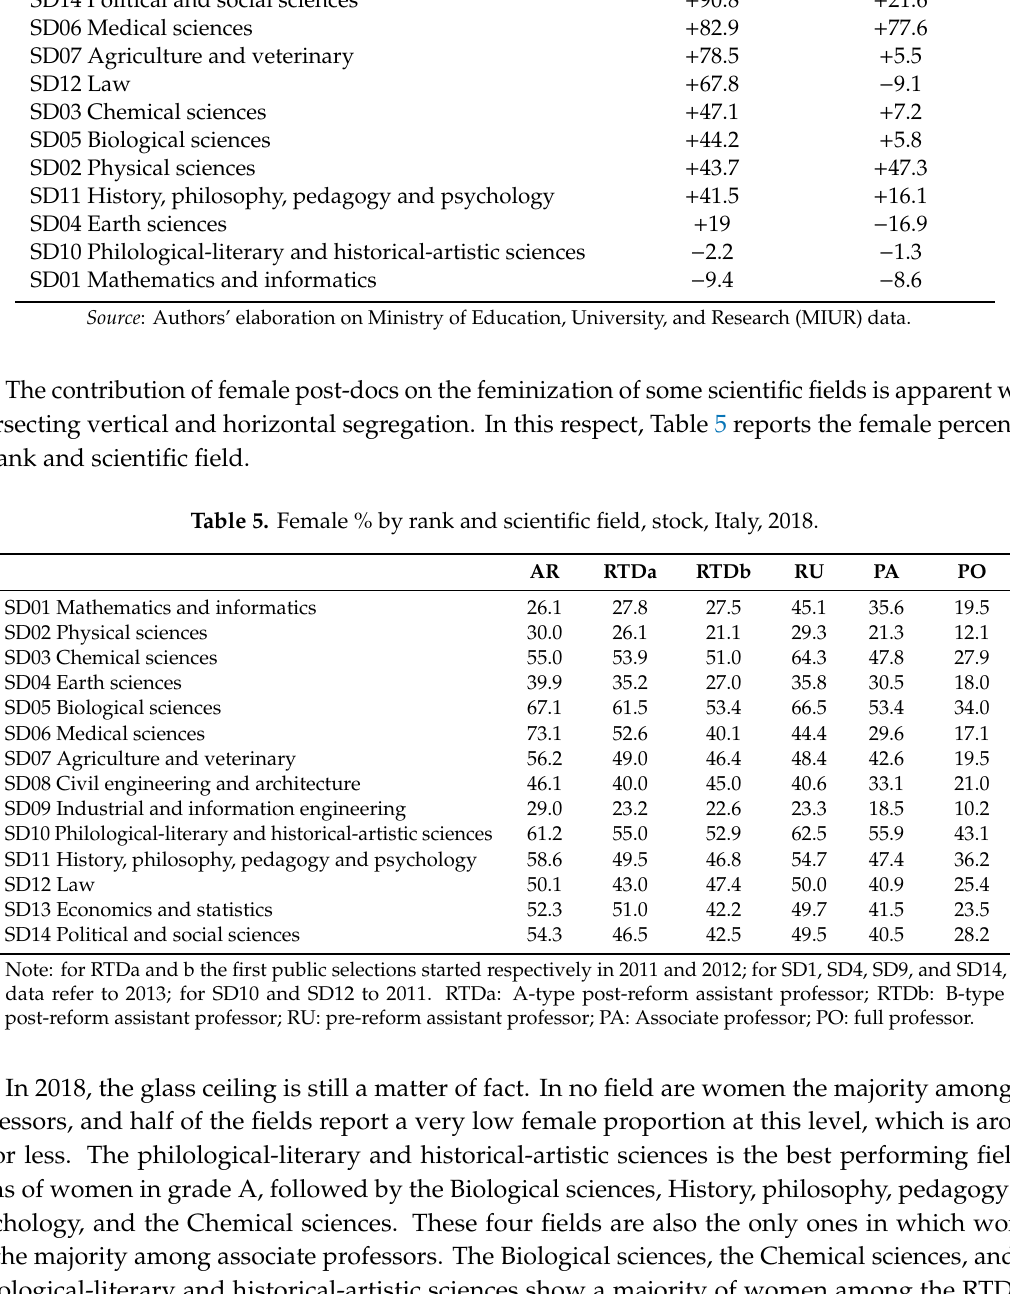
Stock Recruitments